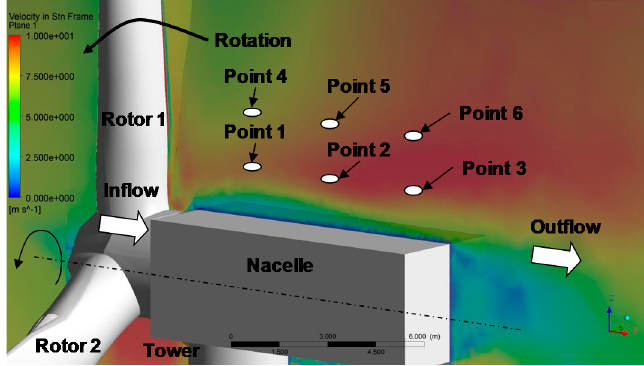
Figure 14. Possible locations of nacelle anemometer.